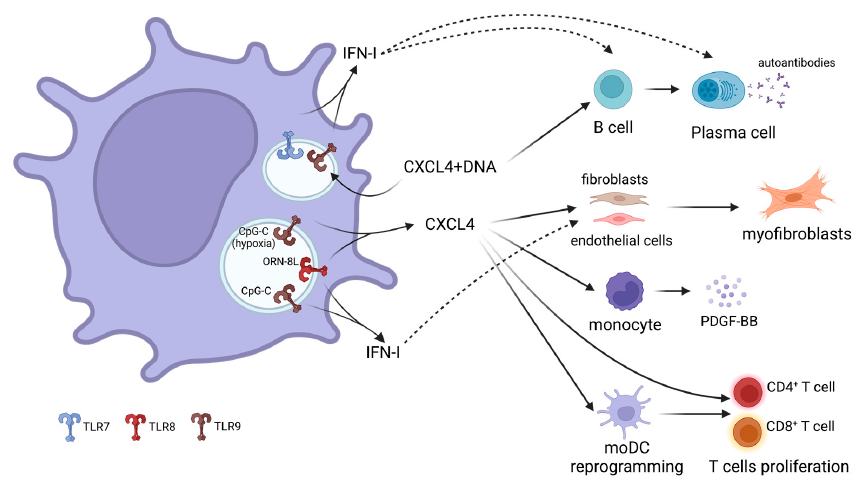
Figure 1. The critical role of CXCL4 in the pathogenesis of SSc. CXCL4 is aberrantly secreted